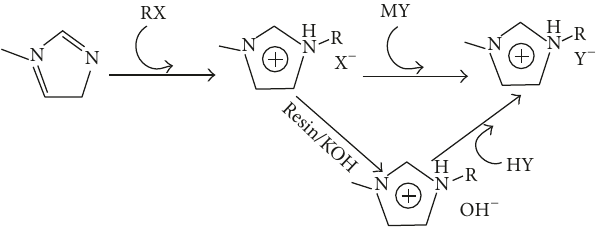
Figure 1: Typical preparation routes for ionic liquids (R = alkyl; X = [DMP] − , Cl − , Br − , I − ; M = Na + , K + ; Y = [AC] −